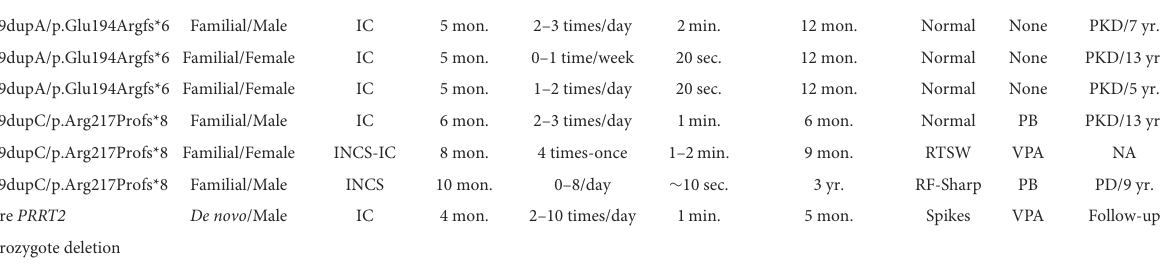
TABLE 1 Genetic and clinical characteristics of patients with feeding-induced infantile convulsion/non-convulsion seizure caused by PRRT2 mutations. Mutation Inheritance/sex Seizure Onset age Frequency Duration Remission